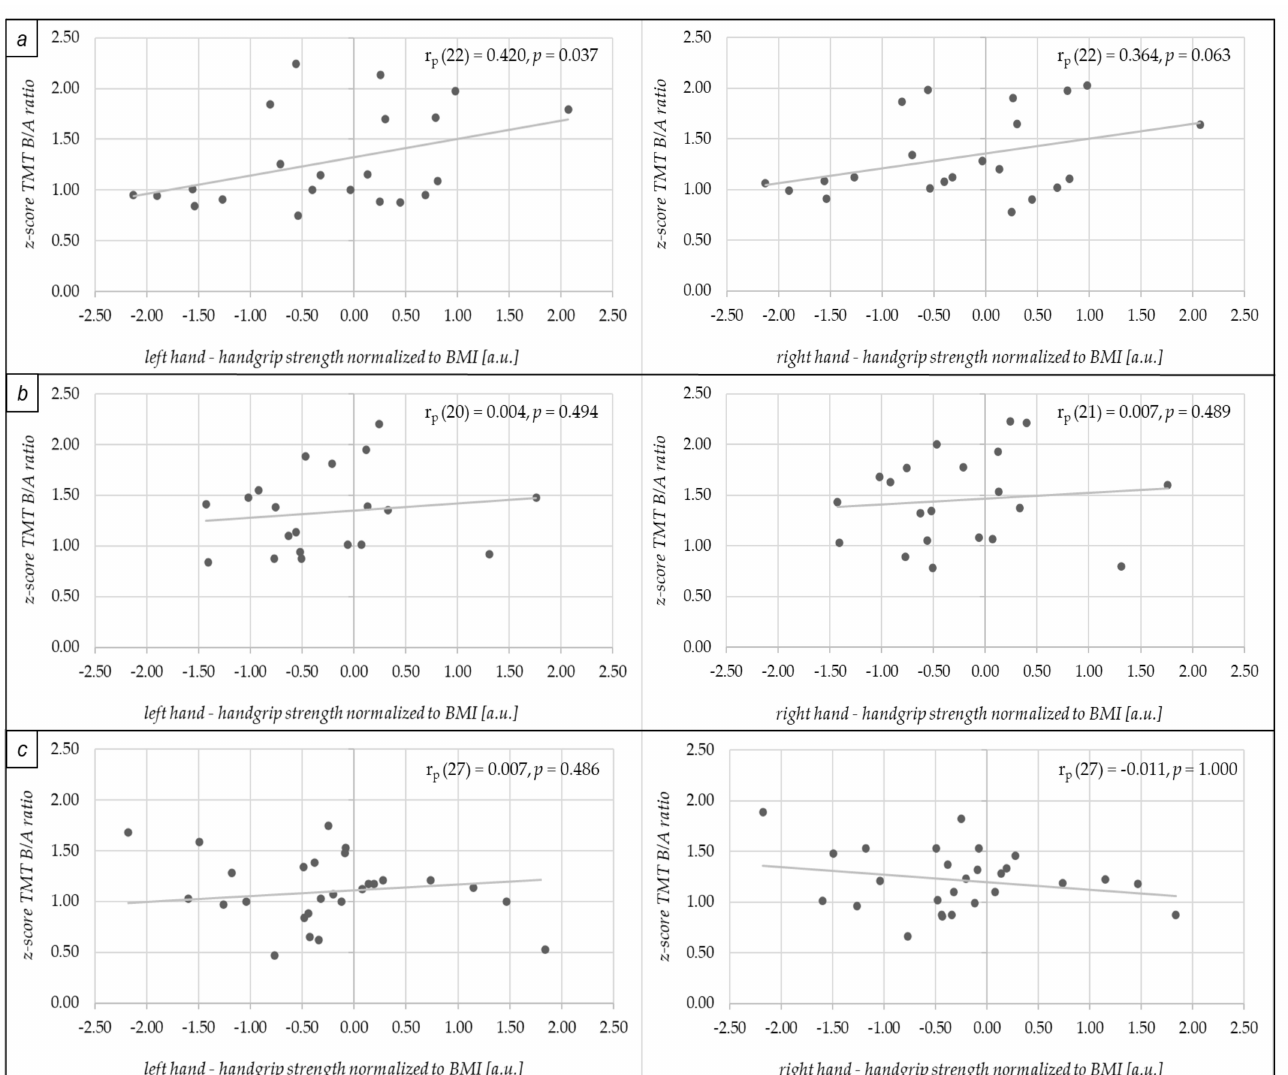
Figure 2. Scatter plots displaying the correlations between normalized handgrip strength (nHGS) of the left hand and right hand and z-scores of TMT B/A ratio (reflecting executive functioning) in the older individuals with amnestic mild cognitive impairment (aMCI) in ( a ), for older adults with non-amnestic mild cognitive impairment (naMCI) in ( b ) and healthy older controls (HC) in ( c ). The handgrip strength was normalized to the Body Mass Index to account for the influence of anthropometrics on handgrip strength [58,59]. a.u.: arbitrary unit; BMI: Body Mass Index; r p : partial correlation coefficient (accounting for age, sex, and severity of depressive symptoms [via scores in Geriatric Depression Scale]); TMT: Trail Making